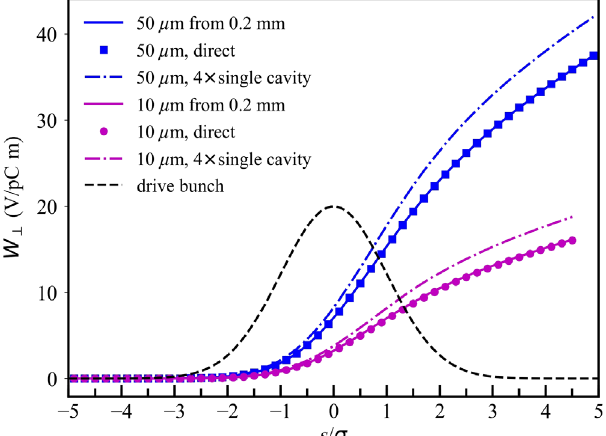
FIG. 9. Comparison of the reconstructed transverse wake potential (solid lines) due to various σ (indicated in legend) with direct simulation for the four-cavity structure (symbols). The dash-dotted lines show four times the wake potential for a single cavity at the indicated bunch